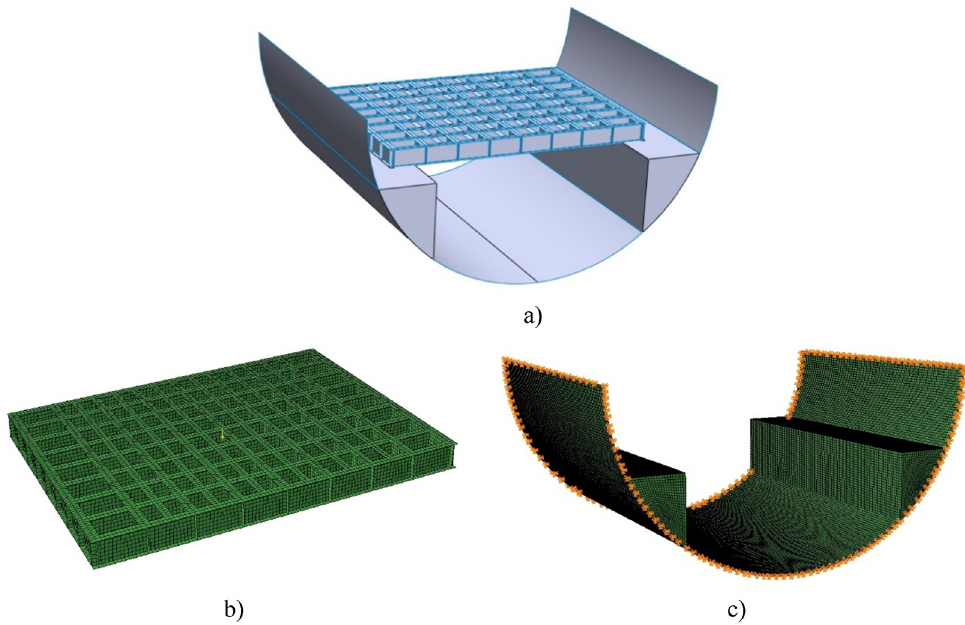
Figure 3: Computational model: ( a ) geometric models, ( b ) concentrated force, and ( c ) boundary